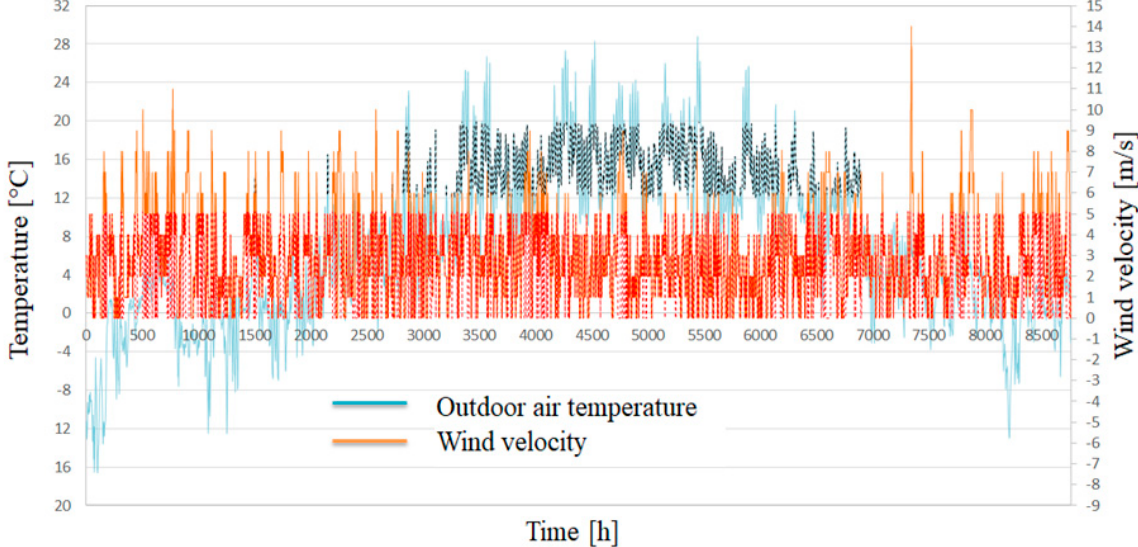
Figure 1. Outside air temperature and wind velocity determined for the city of Elbl ą g based on data from TMR.